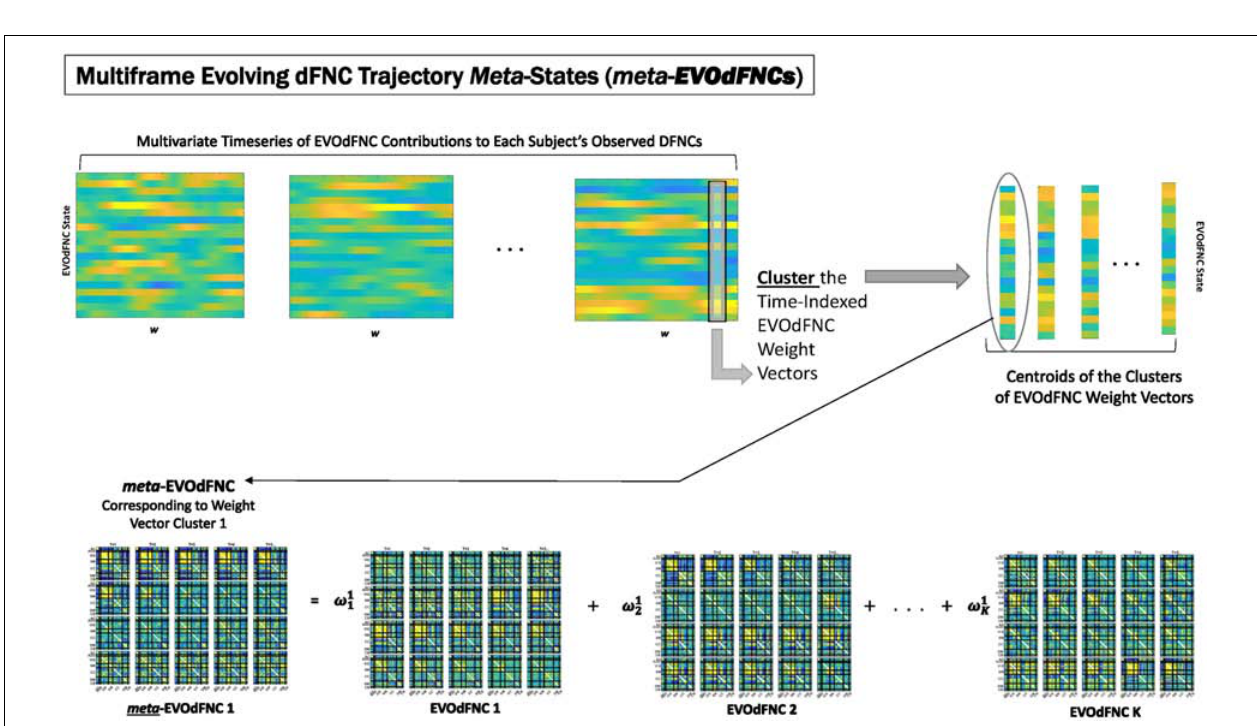
FIGURE 9 | EVOdFNCs are high-dimensional data-driven inverses of exemplar 2D linear trajectories that are relatively sparse in the space of linearized 2D trajectory segments. A fuller range of the structure and dynamics exhibited by actual high-dimensional dFNC observations can be captured by expressing each length- τ observed dFNC sequence as a weighted combination of the EVOdFNCs. From the multivariate EVOdFNC time series we induce a collection of meta-EVOdFNCs by clustering the time-indexed weight vectors (top row) and applying the weight-vector cluster centroids to the EVOdFNC basis states (bottom row).